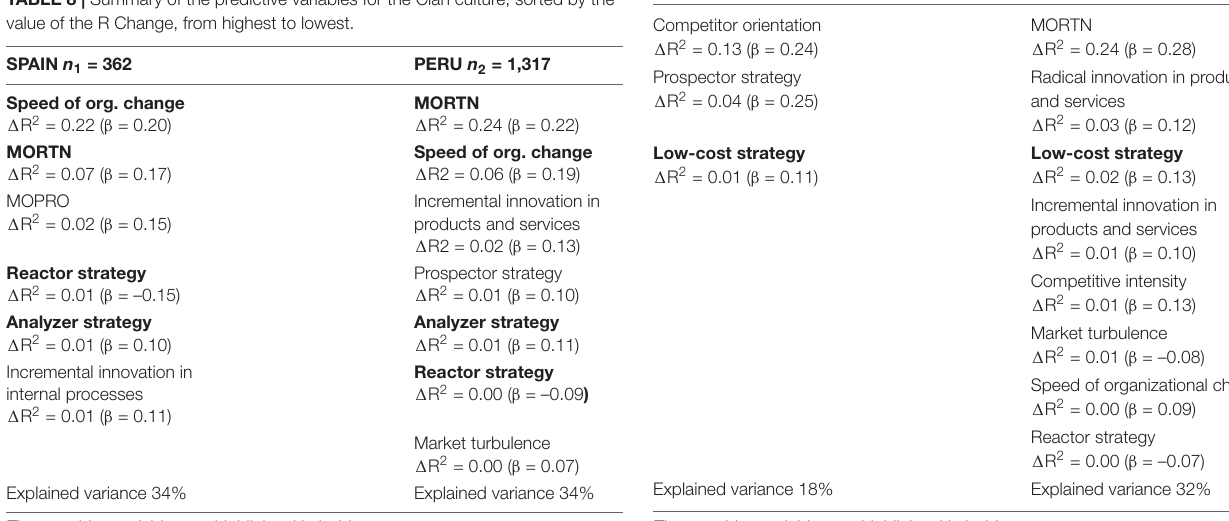
The matching variables are highlighted in